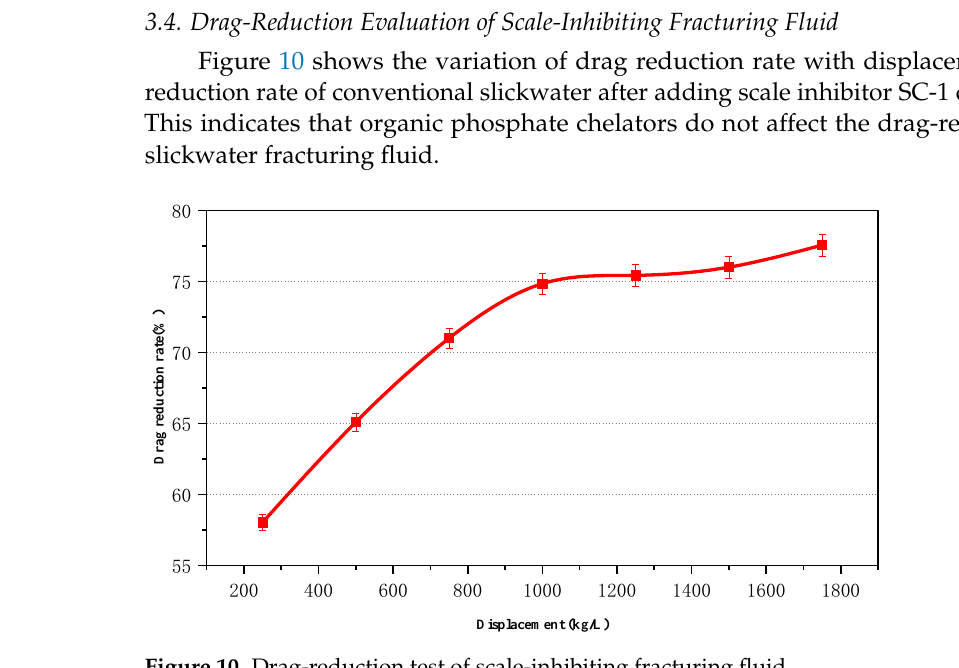
Figure 10. Drag-reduction test of scale-inhibiting fracturing